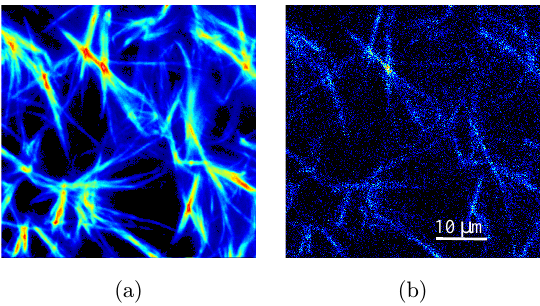
Fig. 6. SHG images of thick collagen matrix acquired by the trans-PMT (a) and epi-PMT (b).